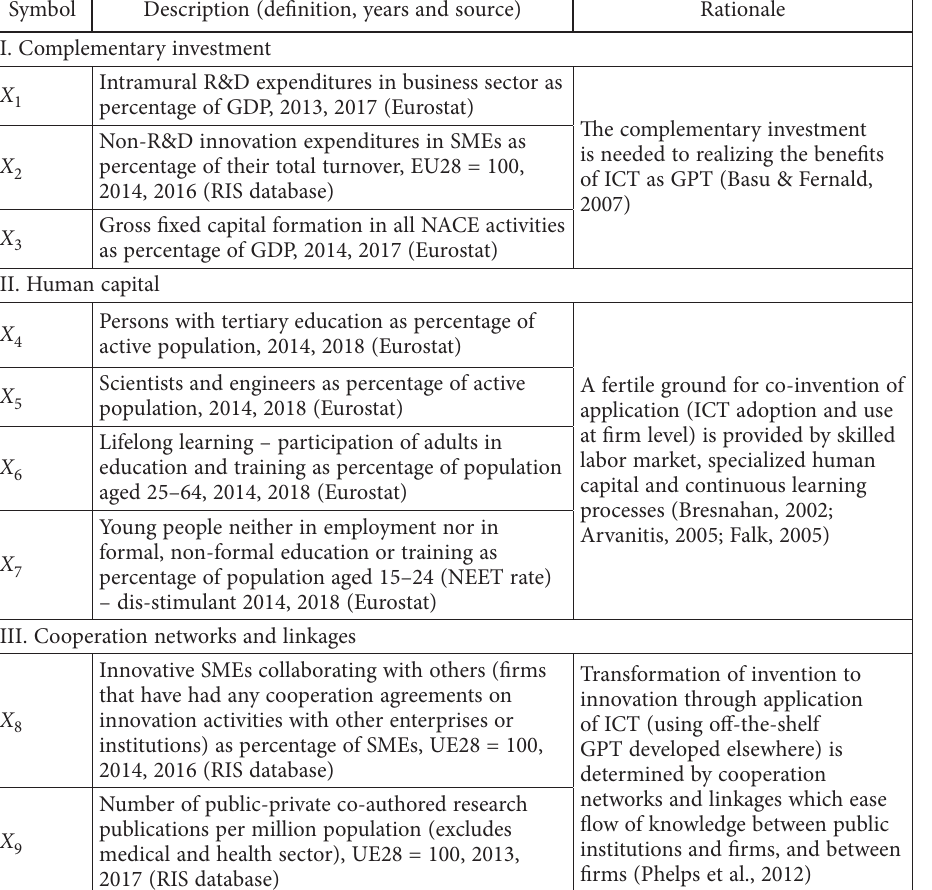
Table 1. Determinants of ICT as GPT adoption and their operationalization (variables) at regional level (source: authors) Symbol Description (definition, years and source)